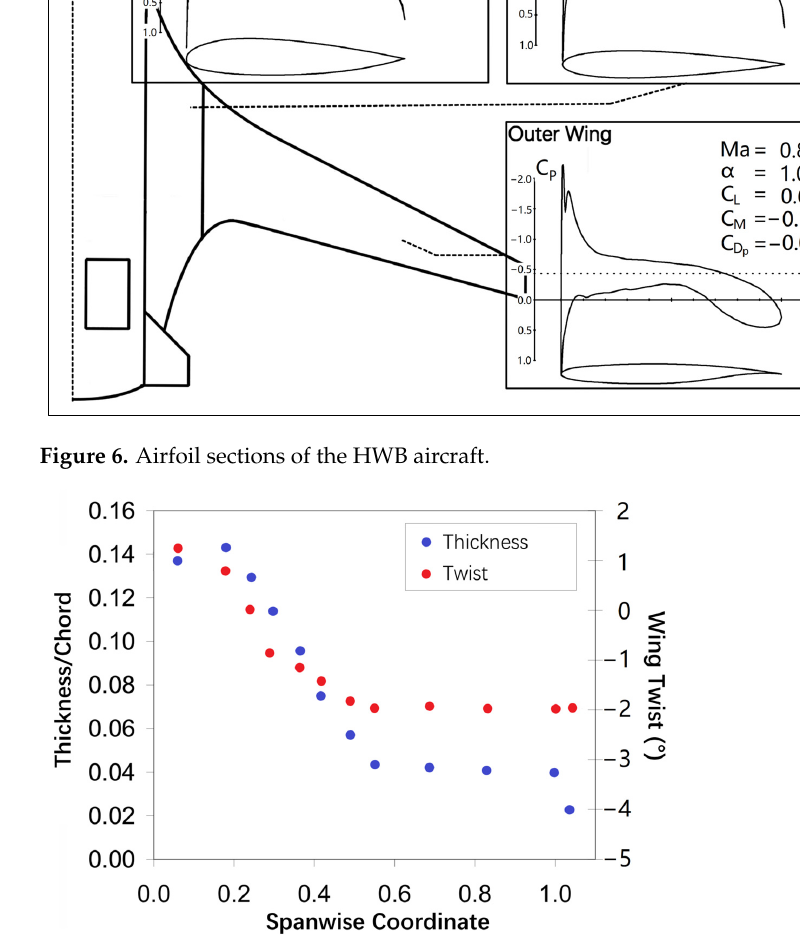
Figure 7. Spanwise distribution of the wing twist and airfoil thickness. Table 1. Flight